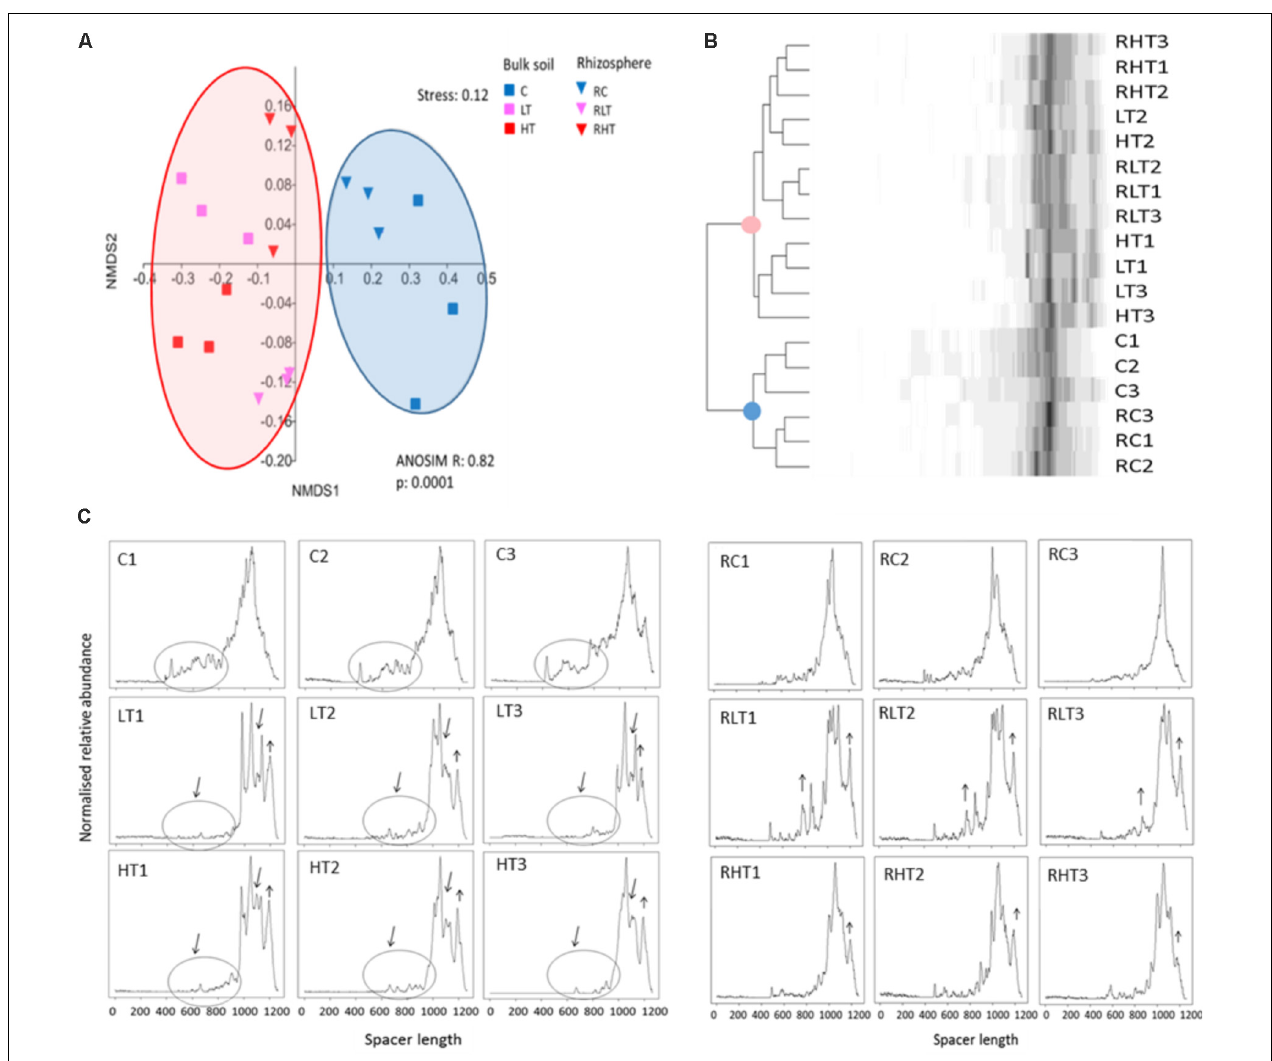
FIGURE 1 | Total microbial communities in polluted soil samples are different from control samples. (A) Multivariate analyses of the Bray-Curtis matrix from ARISA profiles. (B) Dendrogram of the Bray-Curtis matrix and complete clustering method. (C) ARISA electropherograms of bulk soil (left) and rhizosphere (right) with in the X-axis the spacer length (in bp) and in the Y-axis the normalized relative abundance. Sample abbreviations: C, control, LT, low TNT, HT, high TNT location, R, rhizosphere, n = 9 samples per